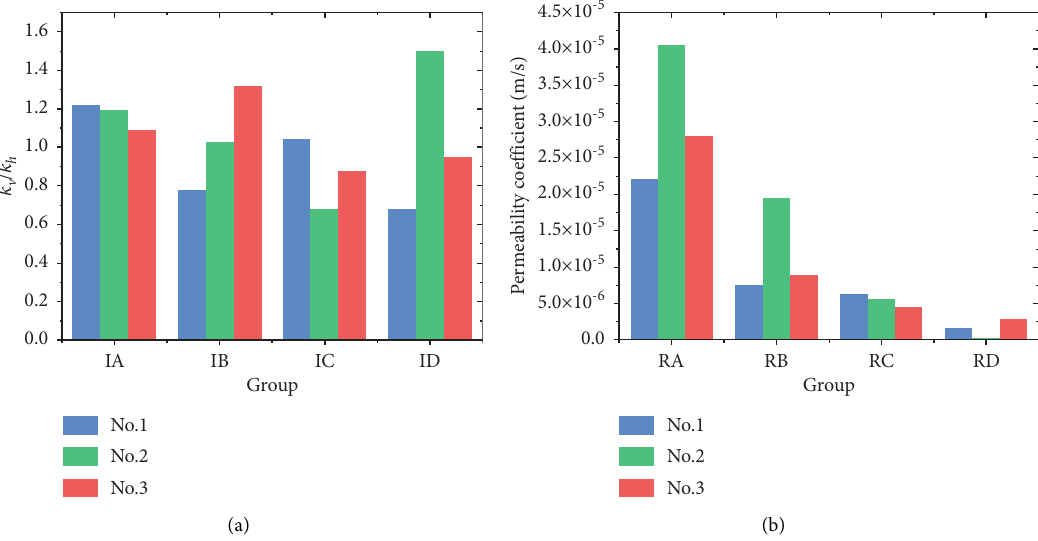
Figure 6: Permeability histogram. (a) The permeability anisotropy of intact loess. (b) The permeability coefficient of remolded